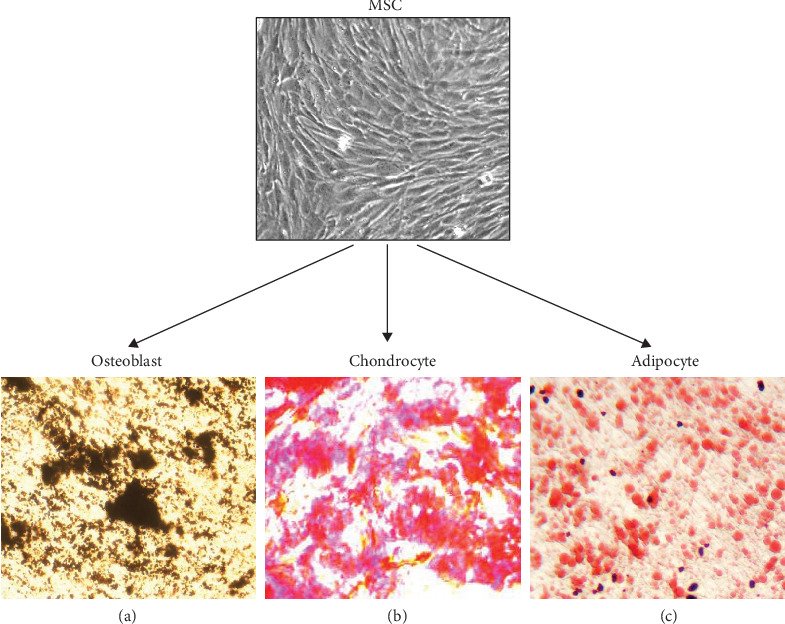
Multilineage differentiation capacity of hUCB-MSCs. The MSCs obtained from umbilical cord blood of the normal group (n = 20) were investigated for their in vitro multilineage differentiation capacity ((a) osteogenesis; (b) chondrogenesis; (c) adipogenesis).